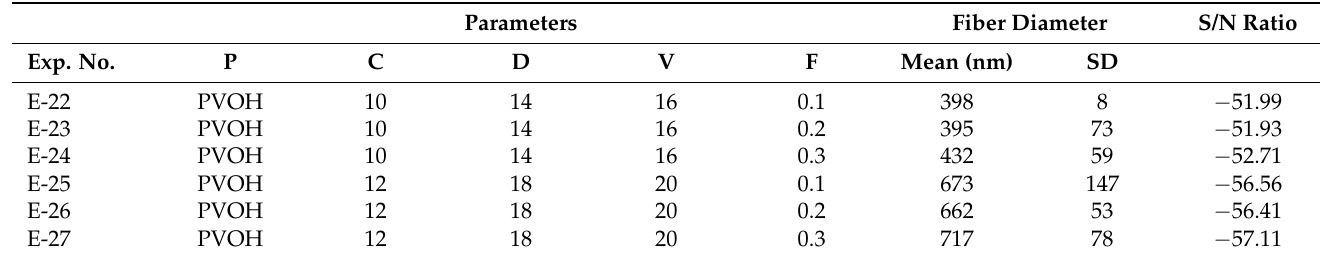
Table 2. Cont. Parameters Fiber Diameter S/N